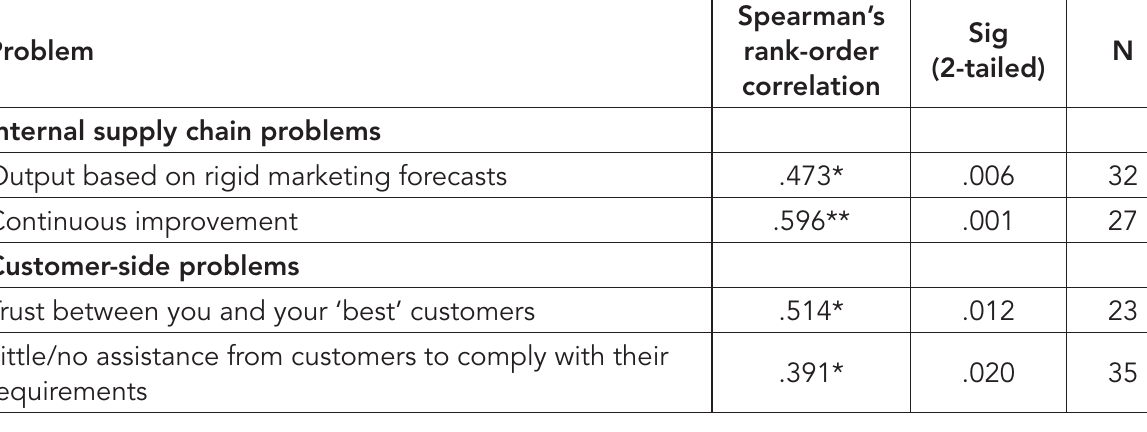
Table 7: Significant correlation between supplier capacity limitations